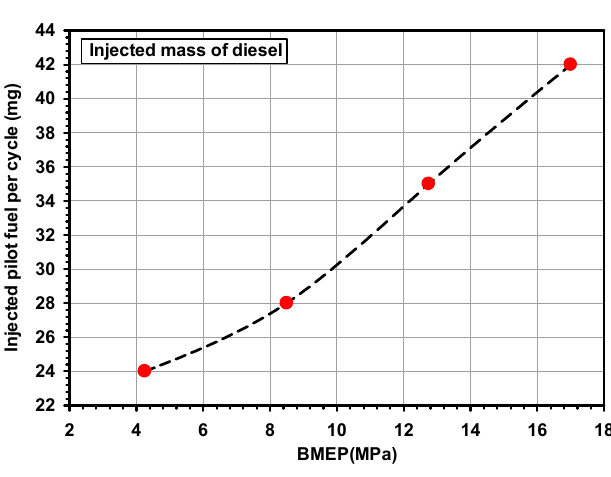
Figure 4. Injected mass of diesel fuel. Table 3. Fuel properties.